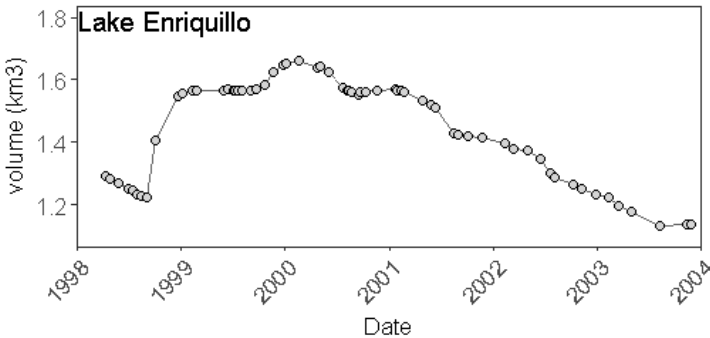
Figure 12. Illustration of closed-lake basin in equilibrium to climatic variation [34] (Reproduced with permission from [34]).